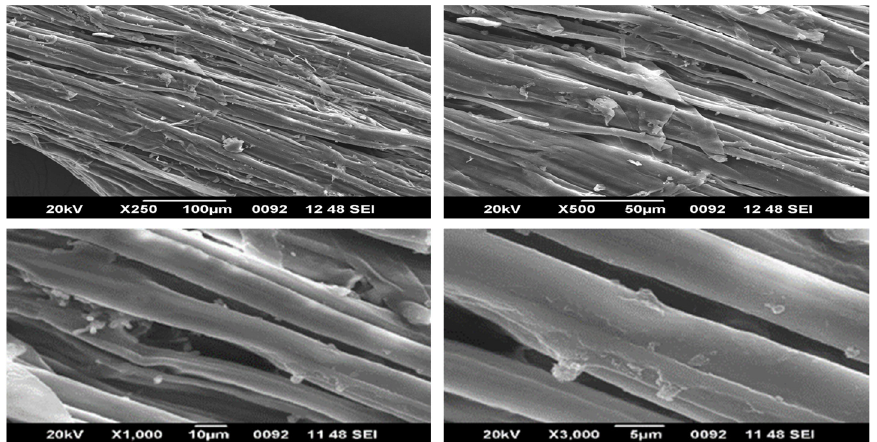
Figure 6. SEM images of raw Zm fi bres.